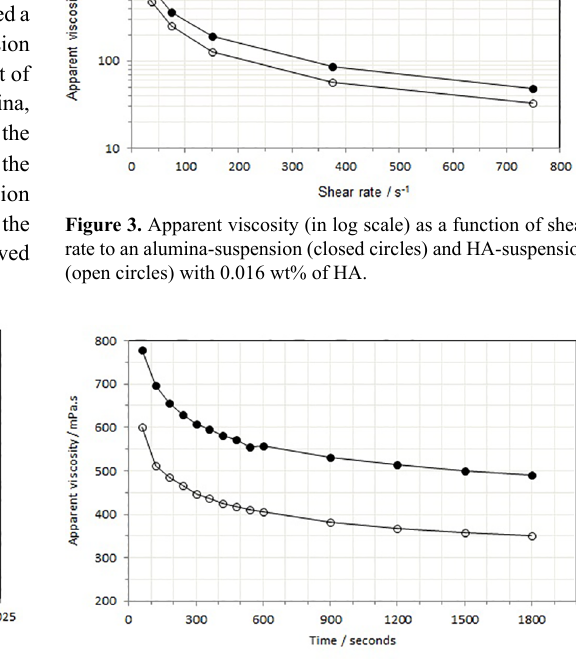
Figure 2. Apparent viscosity of alumina suspension (solid loading of 28 vol%, pH 11) as a function of HA (circles) or sodium polyacrylate (triangles) addition (solutions of 3 g L -1 each). Constant shear rate of 13.2 s -1 .